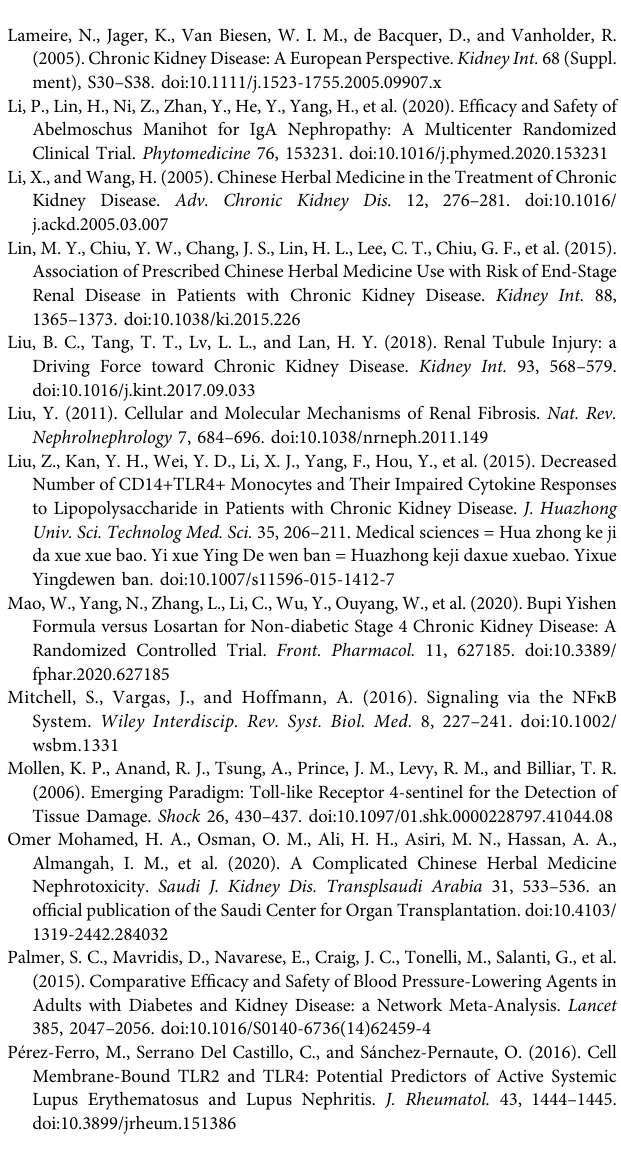
Supplementary Figure S1 | Graphical Abstract Study design: work fl ow used for the study. Supplementary Figure S2 | BYF dose-dependent effect on cell viability by the CCK8 assay after 24